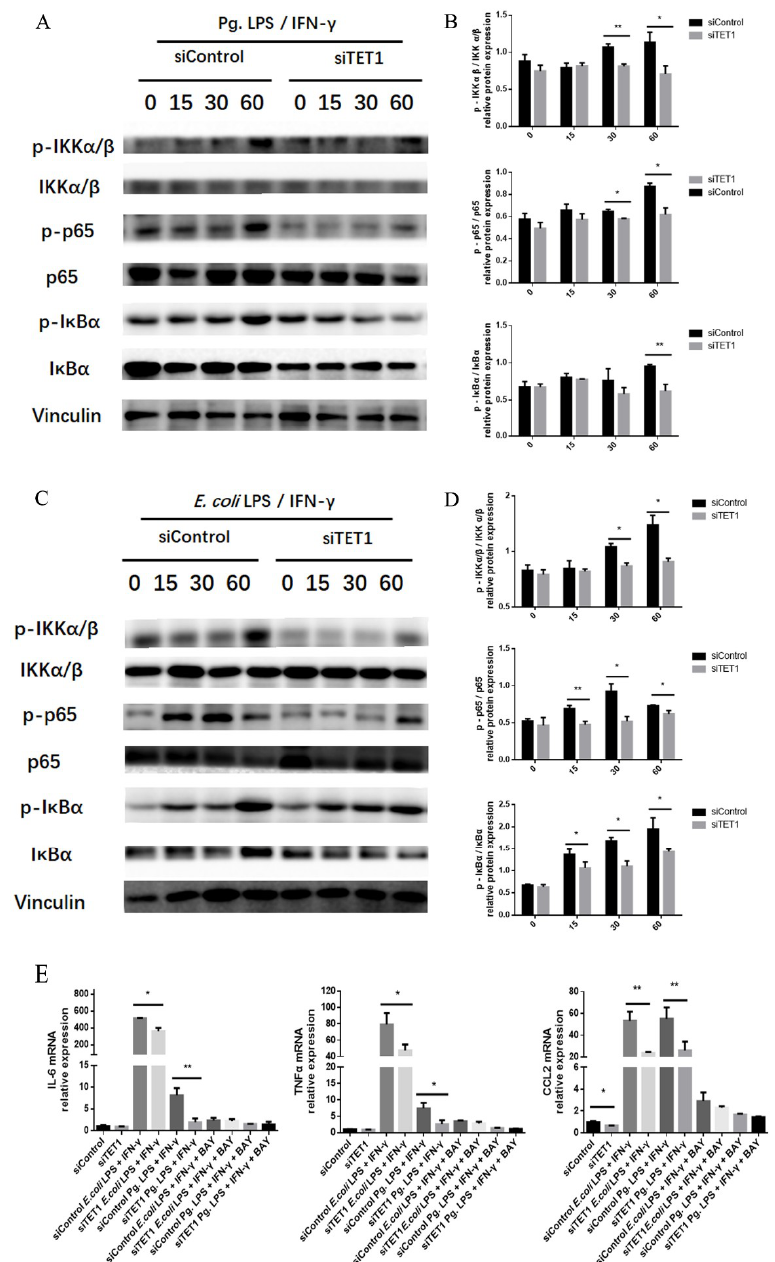
Figure 6. The effect of TET1 depletion on the NF-κB signaling pathway during LPS/IFN-γ-induced Figure 6. The e ff ect of TET1 depletion on the NF- κ B signaling pathway during LPS / IFN- γ -induced M1 M1 macrophage polarization. ( A,C ) The levels of the phosphorylated forms of key NF-κB signaling macrophage polarization. ( A , C ) The levels of the phosphorylated forms of key NF- κ B signaling pathway pathway proteins were measured by Western blot analysis ( A : Pg. LPS/IFN-γ. C : E. coli LPS/IFN-γ). proteins were measured by Western blot analysis ( A : Pg. LPS / IFN- γ . C : E. coli LPS / IFN- γ ). VINCULIN VINCULIN was used as an internal control. ( B,D ) The relative quantitative analysis of the was used as an internal control. ( B , D ) The relative quantitative analysis of the phosphorylation levels phosphorylation levels of IKKα/β, p65, and IκBα was performed by Western blot analysis ( B : Pg. of IKK α / β , p65, and I κ B α was performed by Western blot analysis ( B : Pg. LPS / IFN- γ . D : E. coli LPS / IFN- γ ). ( E ) The mRNA expression levels of IL-6 , TNF- α , and CCL2 were assessed by qRT-PCR with / without pretreatment with the inhibitor BAY11-7082. GAPDH was used as an internal control. All of the results represent the mean ± standard deviation of three independent experiments ( n = 3). * p < 0.05 and ** p < 0.01 represent significant di ff erences compared with the